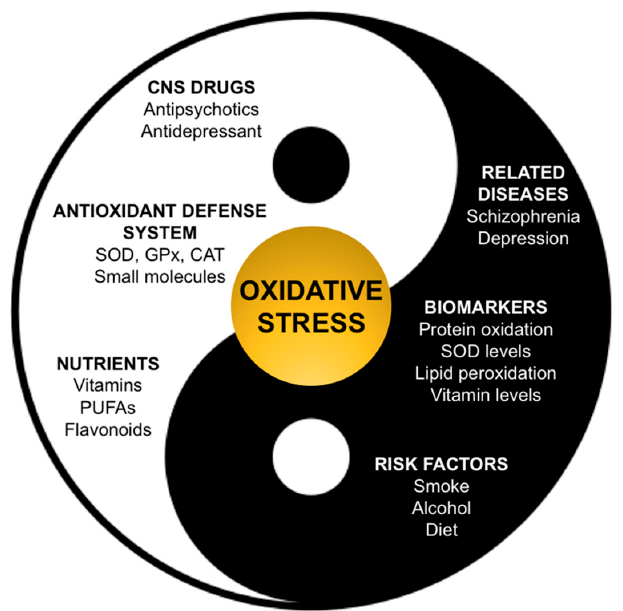
Figure 2. The concept of oxidative stress as a balance between pro-oxidant and antioxidant conditions, which is particularly relevant in the cases of schizophrenia and depression.